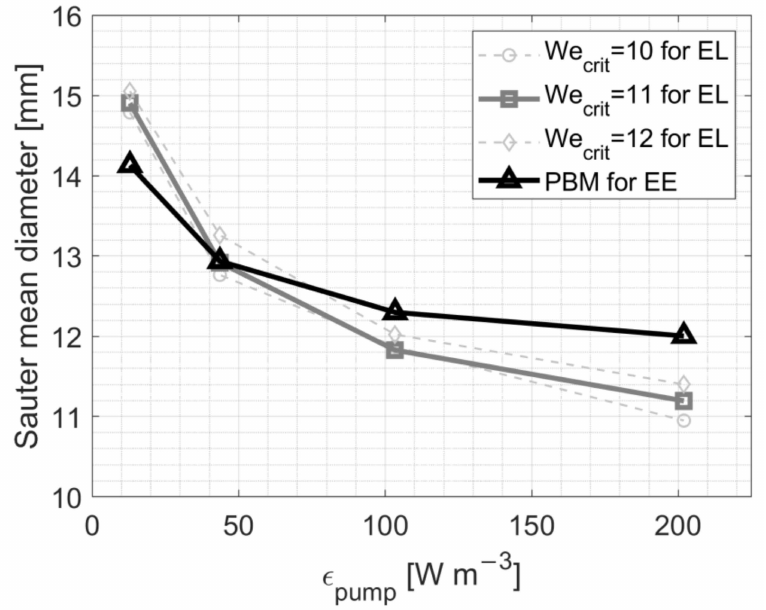
Figure A2. Sauter diameter of the bubble breakage model of Lehr et al. obtained with 4 different energy input rates. The solution from the EE approach and the fitted solution with 3 different critical We numbers are